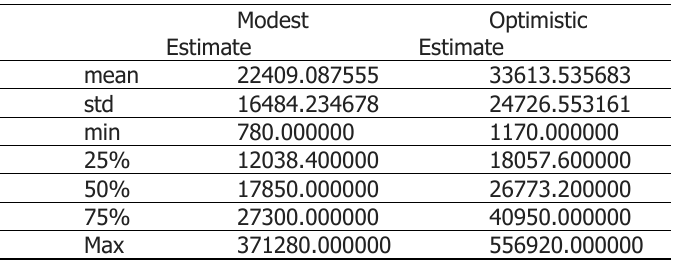
Table 2 Distribution of Modest and Optimistic Income Estimate